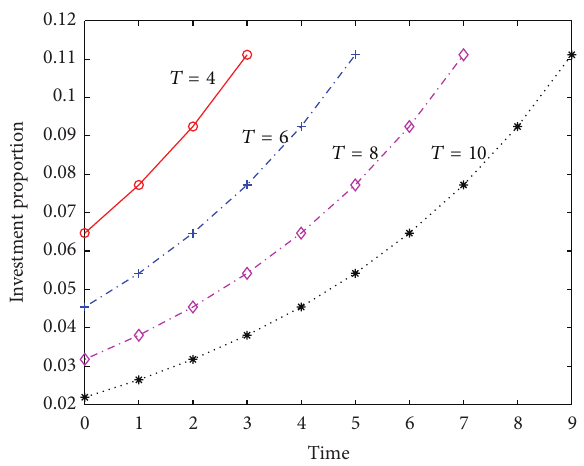
Figure 5: Investment proportions with different time